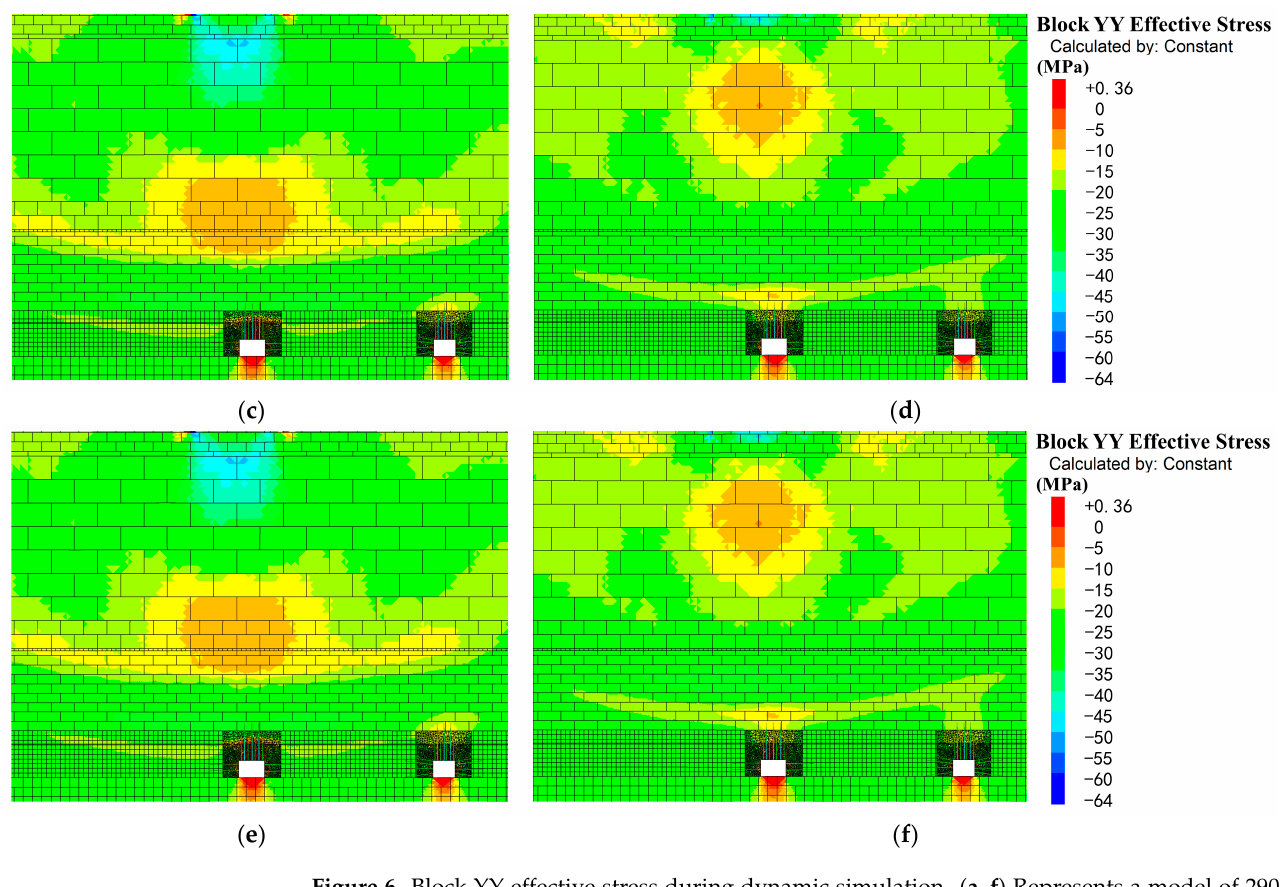
Figure 6. Block YY effective stress during dynamic simulation. ( a – f ) Represents a model of 2900, 3000, 3100, 3200, 3300, 3400 time steps, respectively.